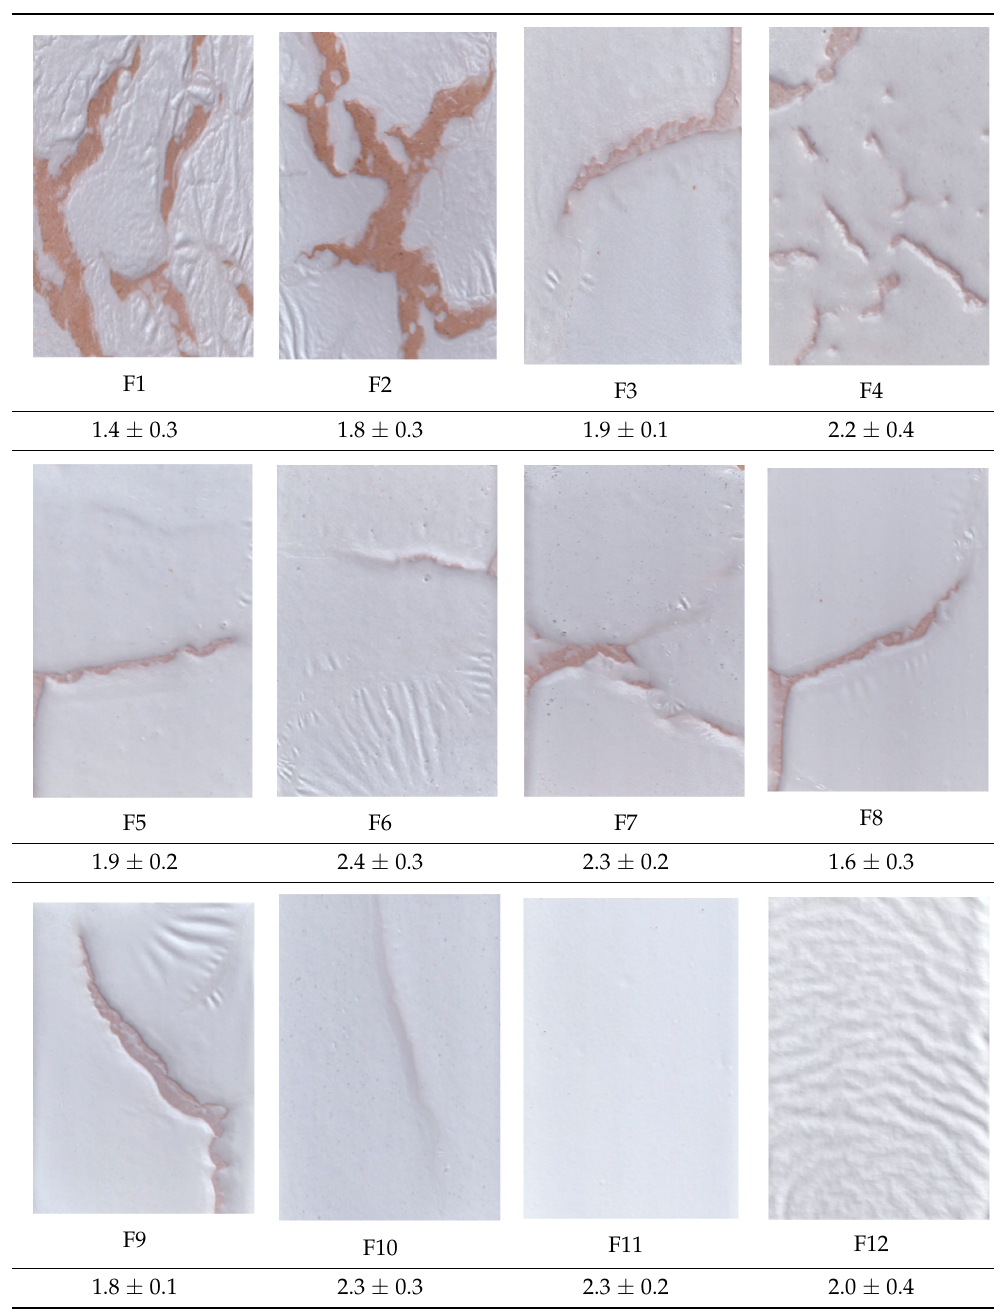
Table 2. Photographic images of acrylic coating formulations applied on HDF surface. The values underneath each formulation identifier represent the average foam thickness in mm (measured only on the regions covered with foam) and the standard deviation of that